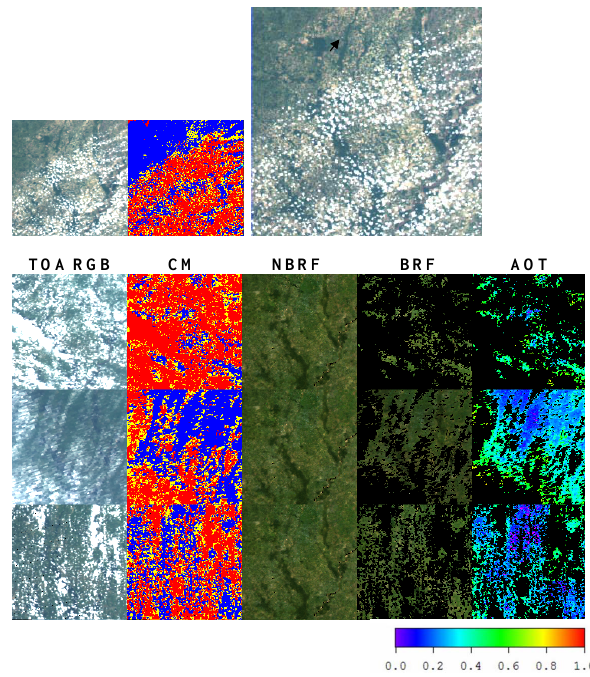
Figure 1 . (Top) Effect of spatial resolution on detection of small clouds. The left and right images show the MODIS Aqua RGB image of the 150×150km 2 area in Georgia, USA, for June 29, 2003 at gridded resolution of 1km and 500m, respectively. The MAIAC cloud mask (CM) is shown in the middle with the following legend: Blue - Clear, Red/Yellow - Cloud. (Bottom) Illustration of MAIAC performance for the same area in August 5-7, 2003. The five columns show the MODIS Aqua TOA data and MAIAC products including cloud mask, RGB NBRF (bidirectional reflectance computed from the BRDF model for a fixed view geometry of nadir view and 45 ° solar zenith angle), BRF (or surface reflectance) and aerosol optical thickness (AOT 0.47 ) with scale shown below.